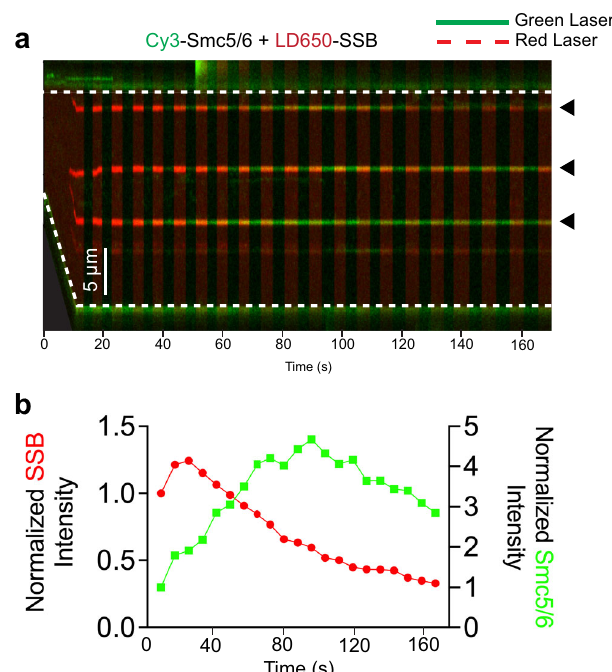
Fig.4|Smc5/6stablybindstoreplicationforks.a Schematic showing a forked DNA tethered between two beads under LF. The intrinsic fork is located one quarter distance of the total tether length from the proximal bead. b Representative kymograph of a forked DNA tether in the presence of 5nM Cy3-Smc5/6 (green). Stable binding of Smc5/6 at the intrinsic fork position was observed on 10 out of 22 (45%) tethers tested. c Quanti fi cation of the Smc5/6 fl uorescence signals at the intrinsic fork (marked by the black arrow in panel b ) over time. Data points indicate the averaged photon count per frame ( n = 10 frames) at the fork site and error bars represent standard